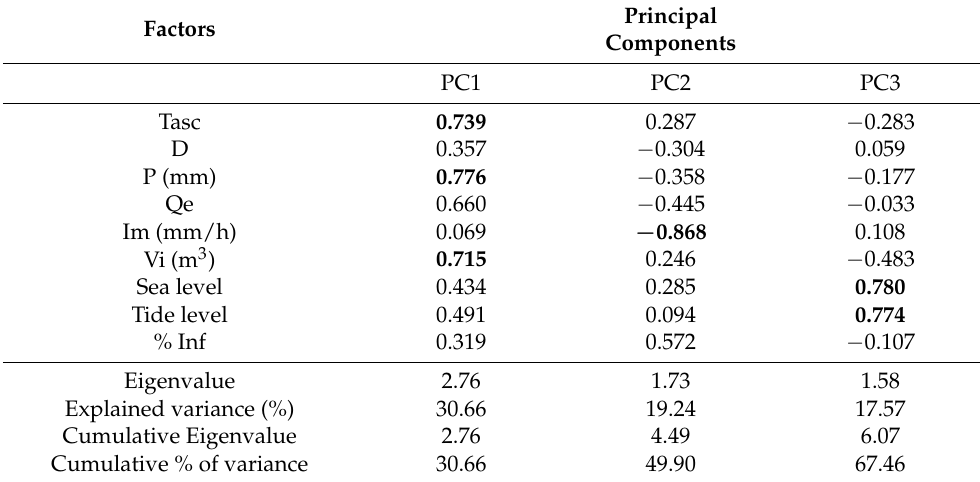
Table 3. Principal component loading and explained variance for the three components.